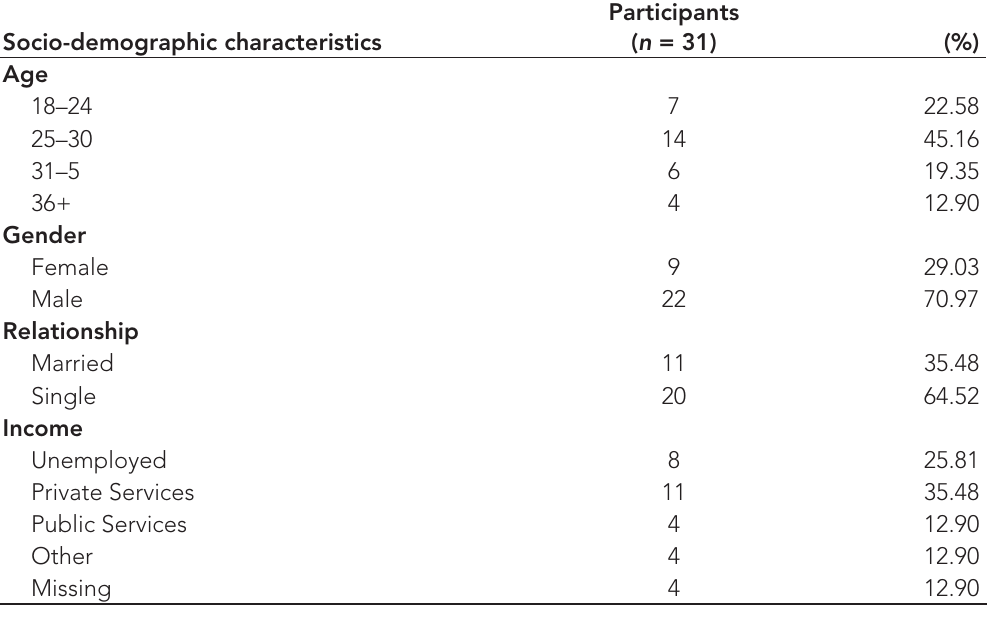
Table 1: Socio-demographics characteristics Socio-demographic characteristics